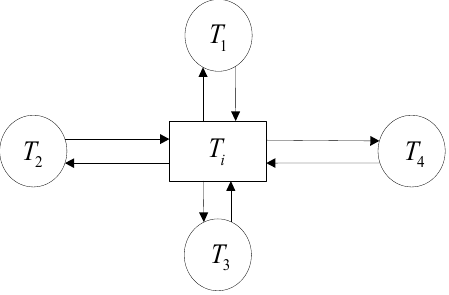
Figure 4. The temperature of a node heat balance system.